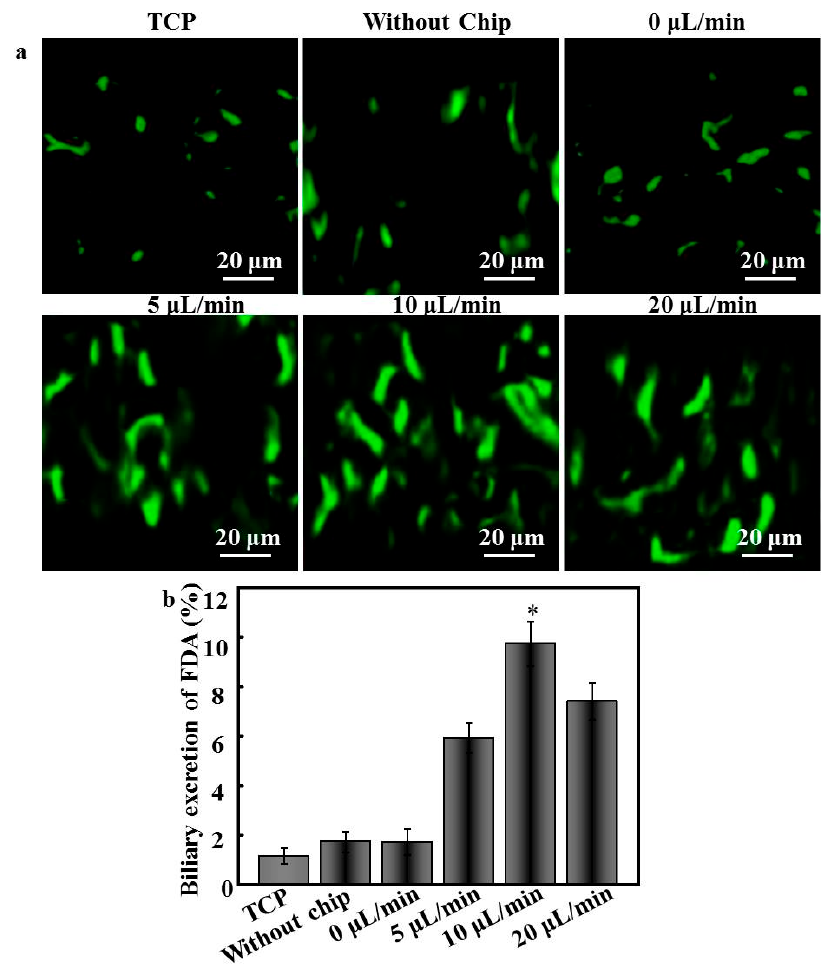
Figure 6. ( a ) CLSM images of fluorescein diacetate (FDA)-stained hepatocytes cultured on different substrates for 15 days; ( b ) quantification of fluorescence intensity of FDA-containing cells cultured for substrates for 15 days; ( b ) quanti fi cation of fl uorescence intensity of FDA-containing cells cultured for 15 days ( n = 5); * p < 15 days ( n = 5); * p < 0.05.